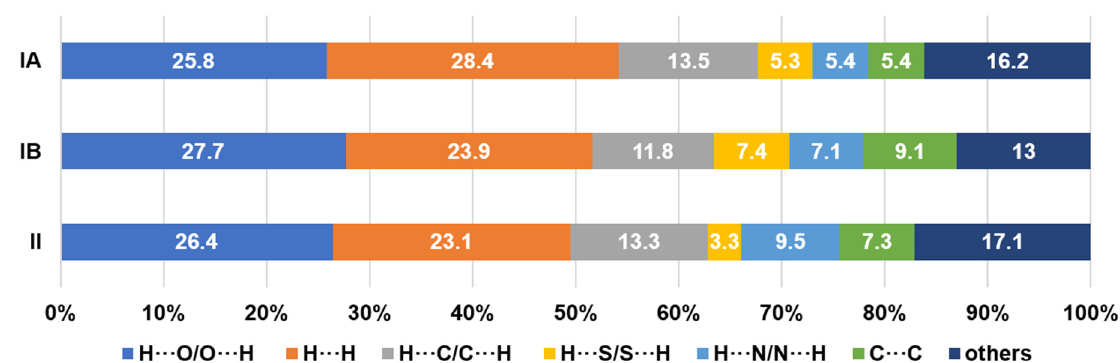
Figure 8. Percentage contributions of non-covalent intermolecular connections.